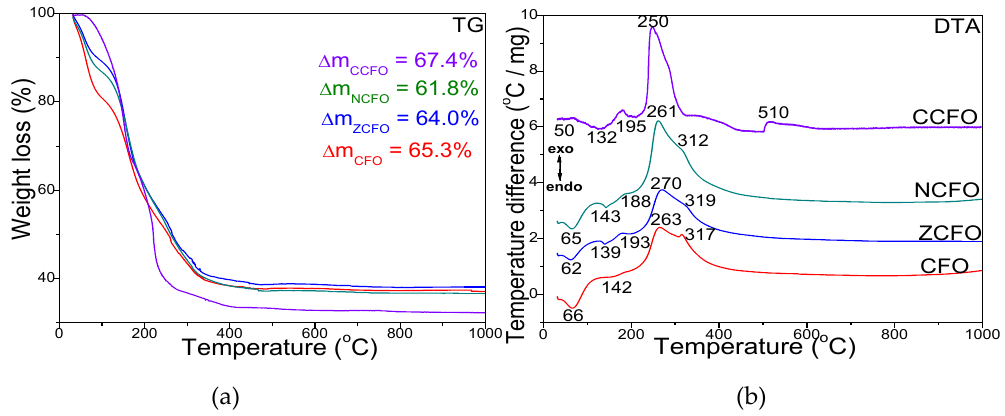
Figure 1. Thermogravimetric (TG) ( a ) and di ff erential thermal analysis (DTA) ( b ) diagrams of CFO, ZCFO, NCFO, and CCFO dried at 40 ◦